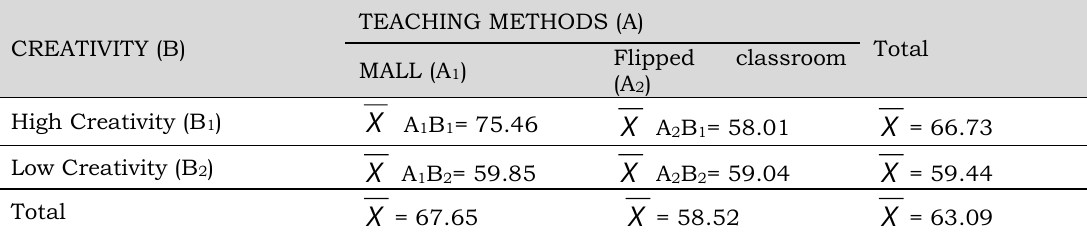
Table 9. The mean scores summary